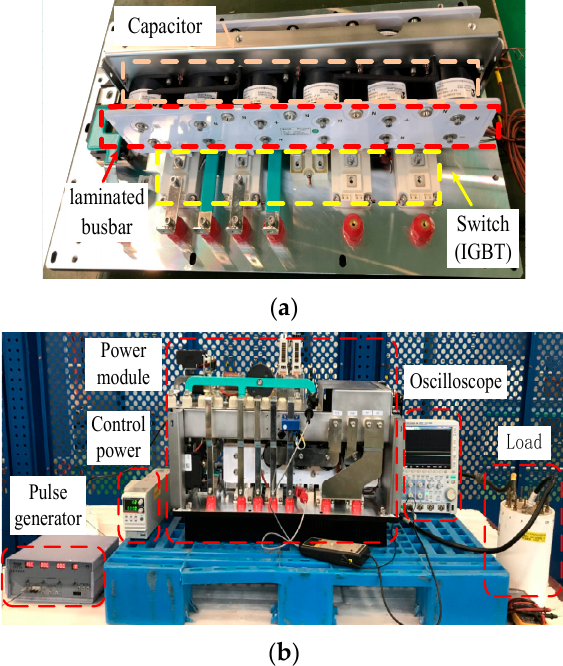
Figure 18. Novel auxiliary power circuit and experimental platform. ( a ) Laminated busbar prototype. ( b ) Experiment platform.